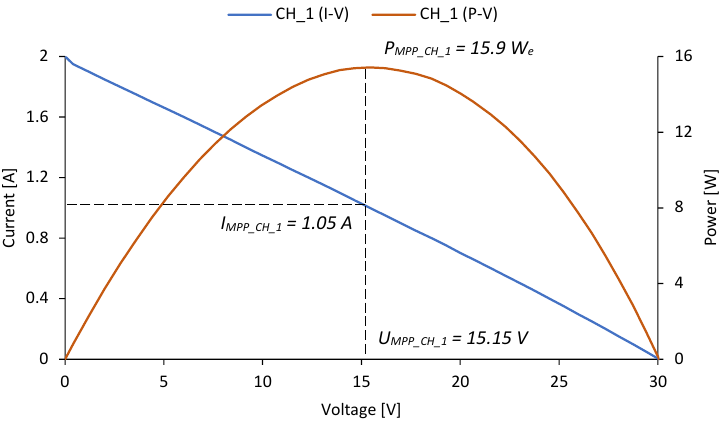
Figure 10, the short circuit current ( I sc_CH_1 ) achieved a maximum value of 2.0 A, and the open circuit voltage ( U oc_CH_1 ) achieved a maximum value of 30.1 V. As a result of the measured current and voltage values, the P – V characteristics were determined. The maximum power attained ( P MPP_CH_1 ) was 15.9 ±0.1 W e for a matched load current ( I MPP_CH_1 ) of 1.05 A and a matched load voltage ( U MPP_CH_1 ) of 15.15 V.